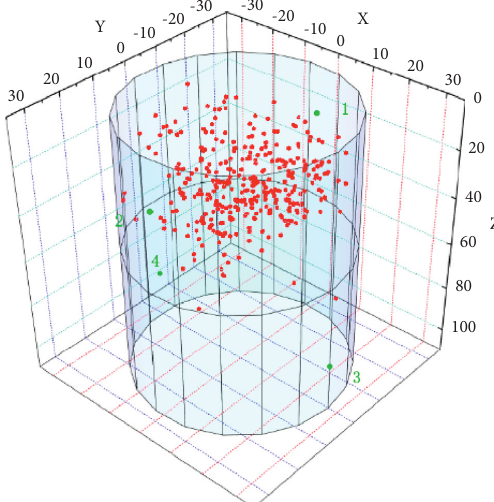
Figure 11: The result diagram of acoustic emission source location result diagram.